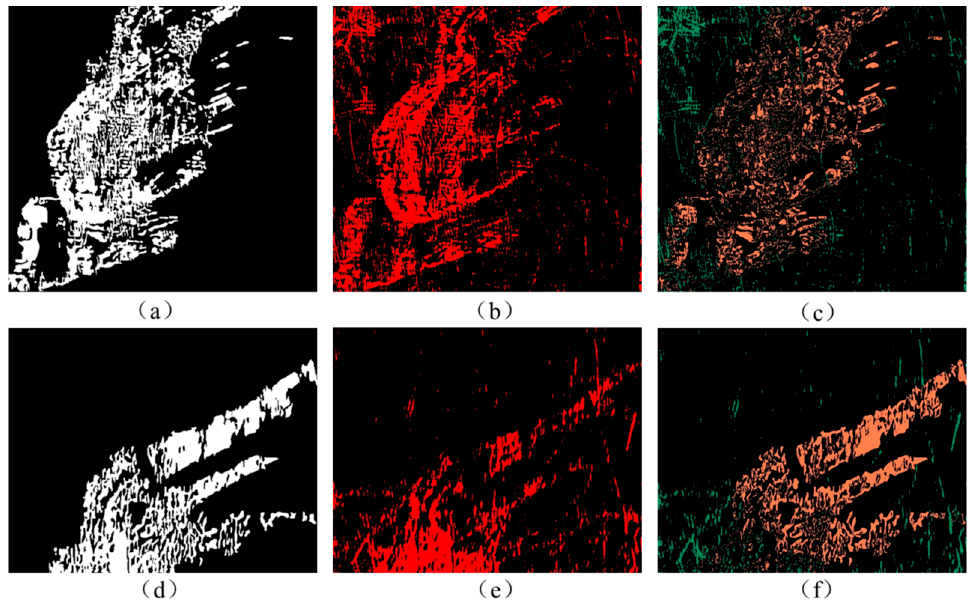
Figure 8. The extraction results of the hidden information of ( a – c ) area 1 and ( d – f ) area 2 using classification methods. ( a , d ) Test image drawn manually; ( b , e ) extraction results of density slicing; ( c , f ) di ff erence image generated by subtracting the density slicing image from the test image. Table 1. The overall accuracy of the two areas.